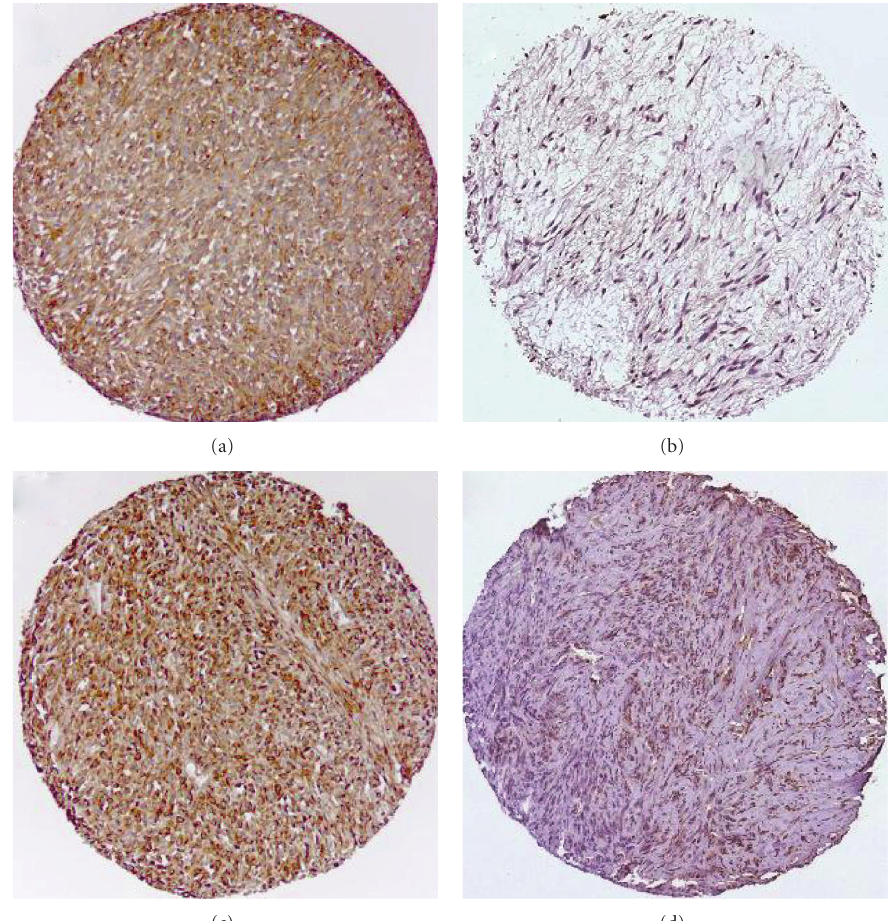
Figure 1: IHC analysis of TMA of nongastrointestinal stromal tumor soft-tissue sarcoma representing di ff erent scores for tumor cell PDGF- B and PDGFR- α . (a) Tumor cell PDGF-B high score; (b) tumor cell PDGF-B low score; (c) tumor cell PDGFR- α high score; (d) tumor cell PDGFR- α low score. Abbreviations: IHC: immunohistochemistry; TMA: tissue microarray; PDGF: platelet-derived growth factor; PDGFR: platelet-derived growth factor